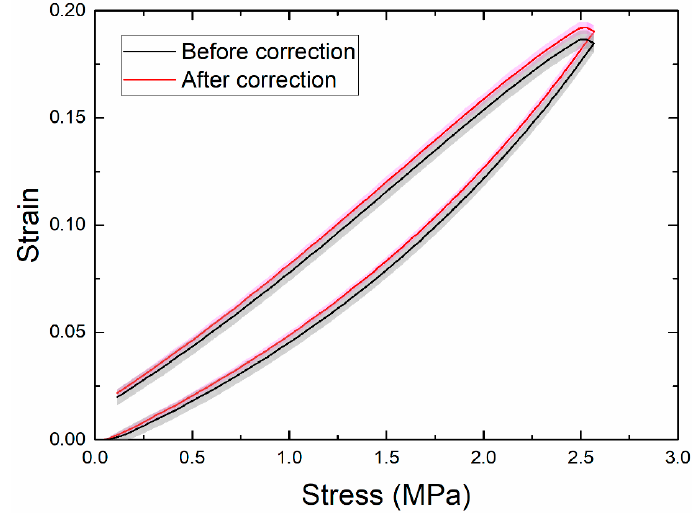
Figure 4. Means and standard deviations of the axial-strain curve at a speed of 10 mm/min. The shaded areas represent one standard deviation of six samples.